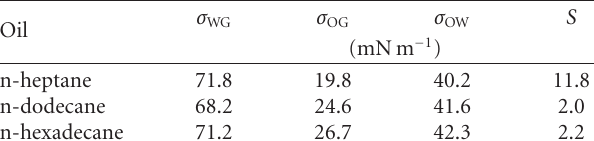
Table 2: Measured values of the surface tensions of the mutually saturated water ( σ WG ) and oil ( σ OG ) phase, interfacial tension ( σ OW ), and spreading coe ffi cient S at 298.2 K